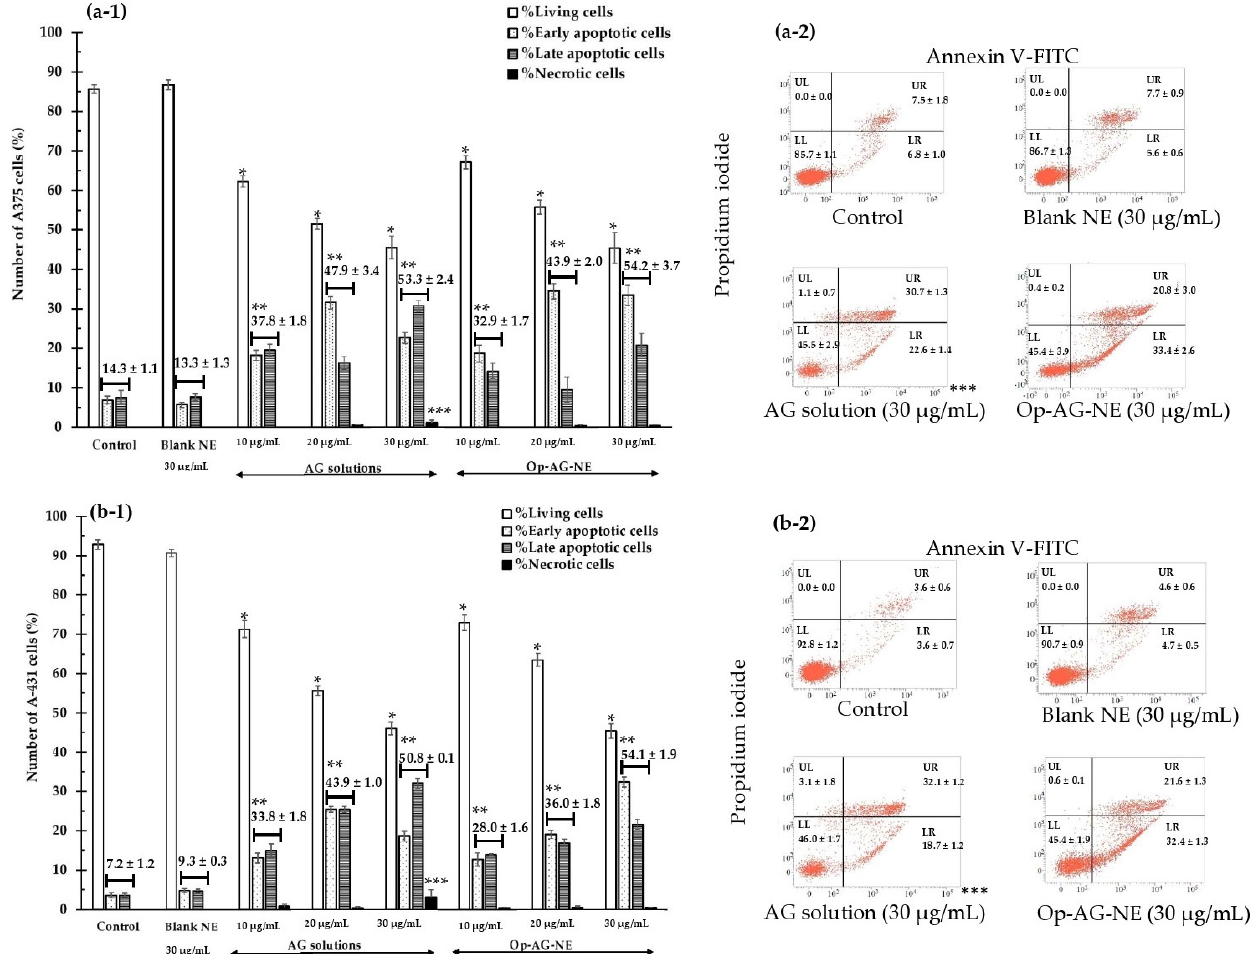
Figure 6. Apoptosis analysis: ( a-1 ) and ( a-2 ) in the A375 cells; ( b-1 ) and ( b-2 ) in the A-431 cells after incubation with Blank NE (30 μ g/mL), AG solution and Op-AG-NE at various equivalent concentrations (mean ± SD, n = 3) (*, ** and *** represent significant difference at p -values < 0.05 when compared to number of the living cells, total apoptotic cells and necrotic cells of the controls, respectively).